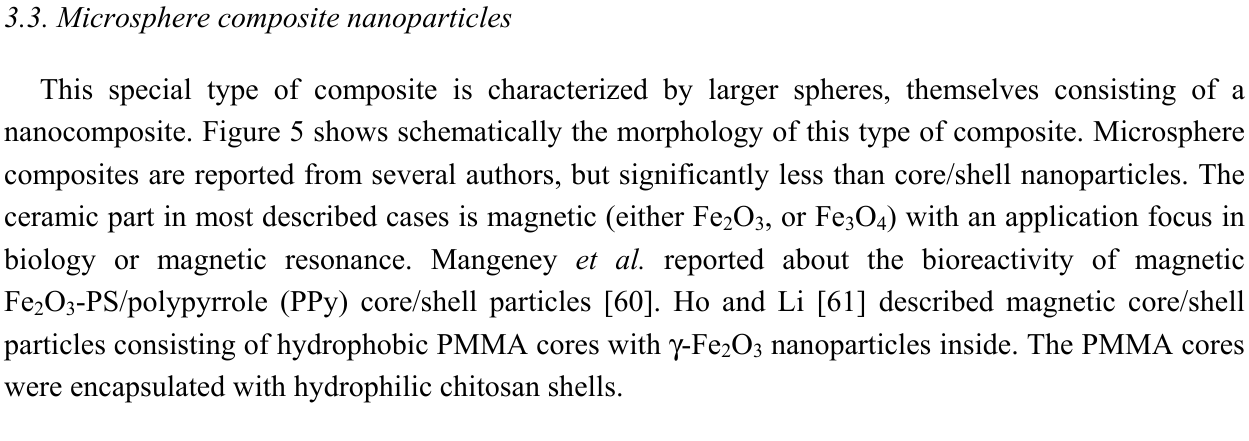
Figure 5 . Morphologies of microsphere composite nanoparticles,